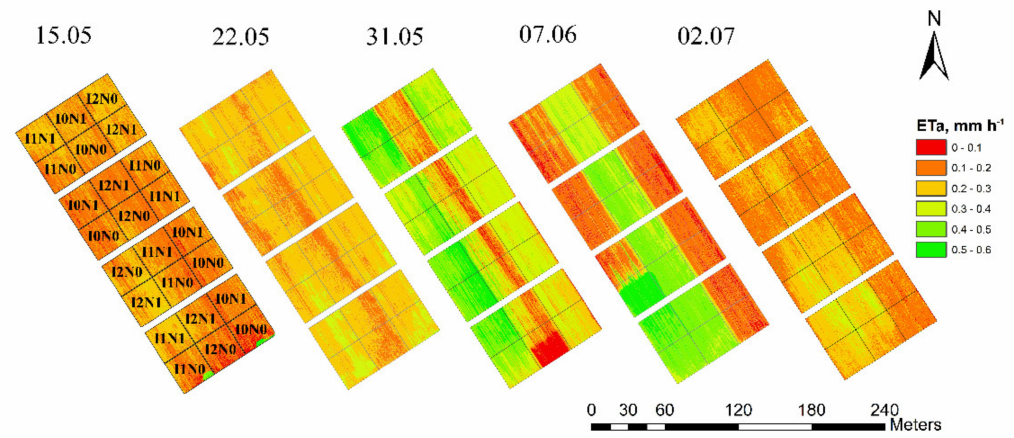
Figure 8. Spatiotemporal dynamics of actual evapotranspiration for winter wheat season in 2018 in Denmark. ET a is the actual evapotranspiration from the surface at the time of the flight in mm h − 1 . I0, I1 and I2 are minimum, optimum and full irrigation, respectively. N0 and N1 are without and with additional fertilization.